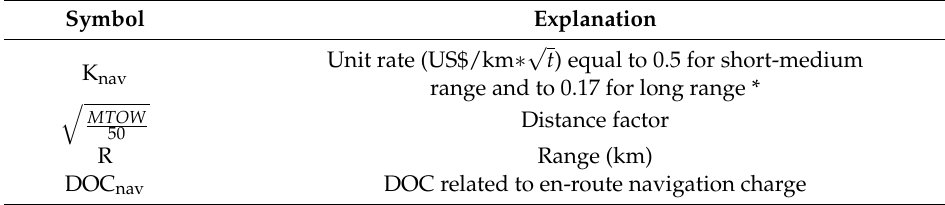
Table 6. Navigation cost symbols